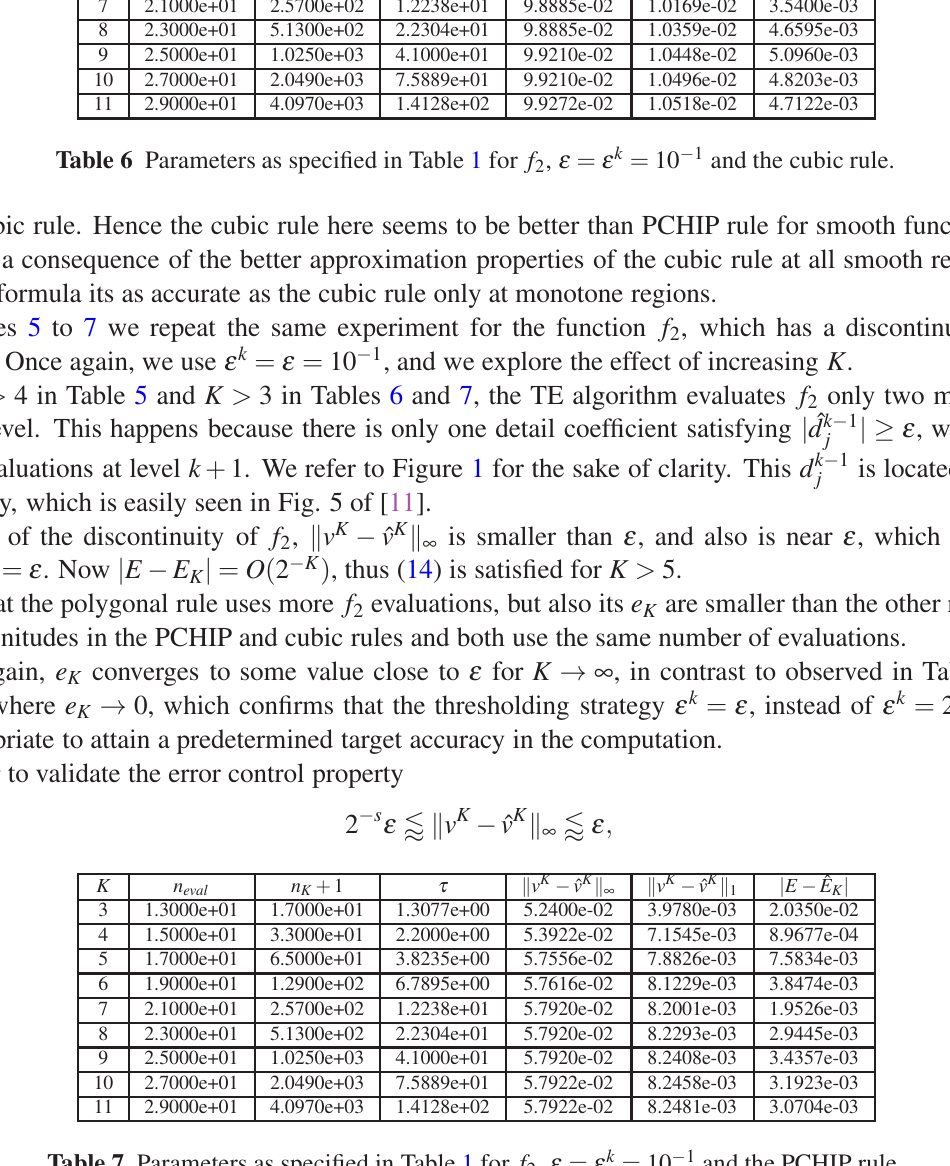
Table 7 Parameters as specified in Table 1 for f 2 , ε = ε k = 10 − 1 and the PCHIP